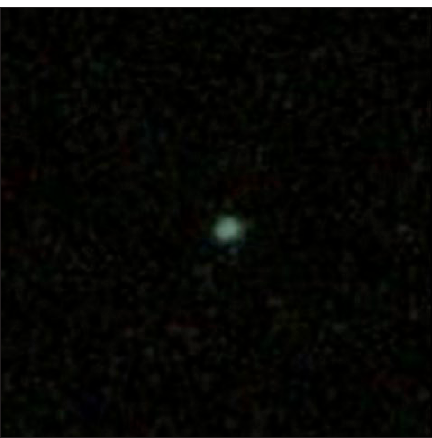
Figure 1: Green Pea: The first Green Pea galaxy posted on the GPAC forum by Hanny on August 12, 2007 (SDSS